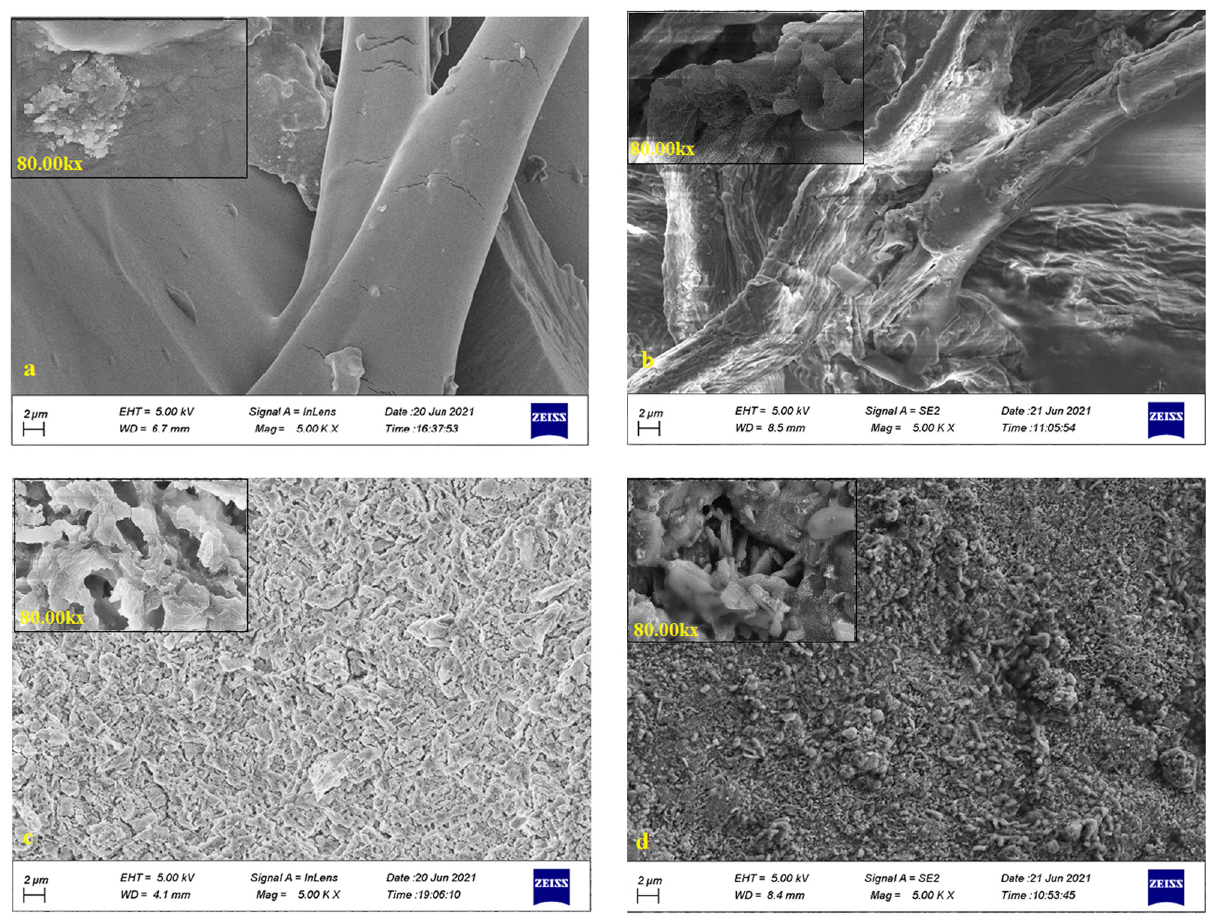
Figure 9: SEM image of ( a ) KPA, ( b ) Mg - PA ( 0.6 g MgCl 2 ) , ( c ) PVA and ( d ) Mg - PVA ( 0.55 g MgCl 2 )